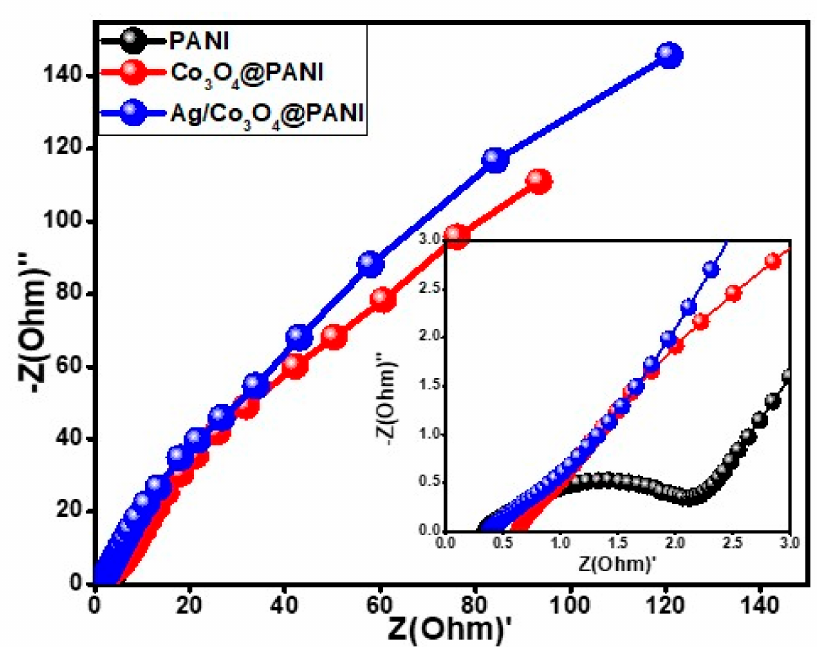
Figure 10. Nyquist plot of pure PANI, Co 3 O 4 @PANI, and Ag / Co 3 O 4 @PANI nanocomposites. Inset figure shows the enlarged high frequency